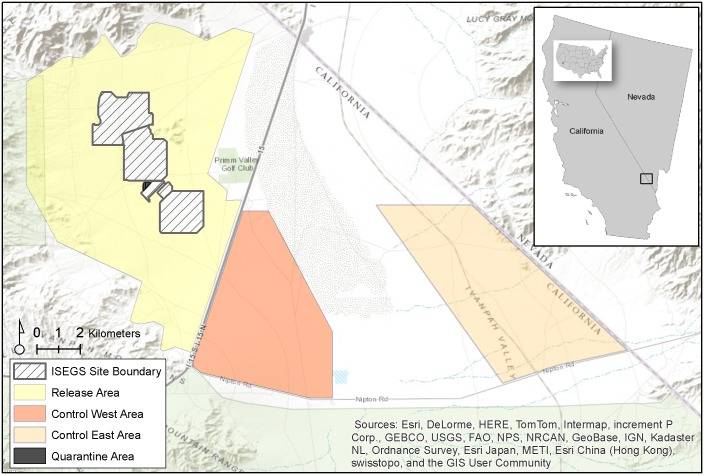
Location of the study area in the Ivanpah Valley of southern California, USA.The Ivanpah Solar Electric Generating System project footprint (white boundary), as well as the locations of the translocated and resident (yellow area), control west (orange), and control east (beige) study groups also are shown.